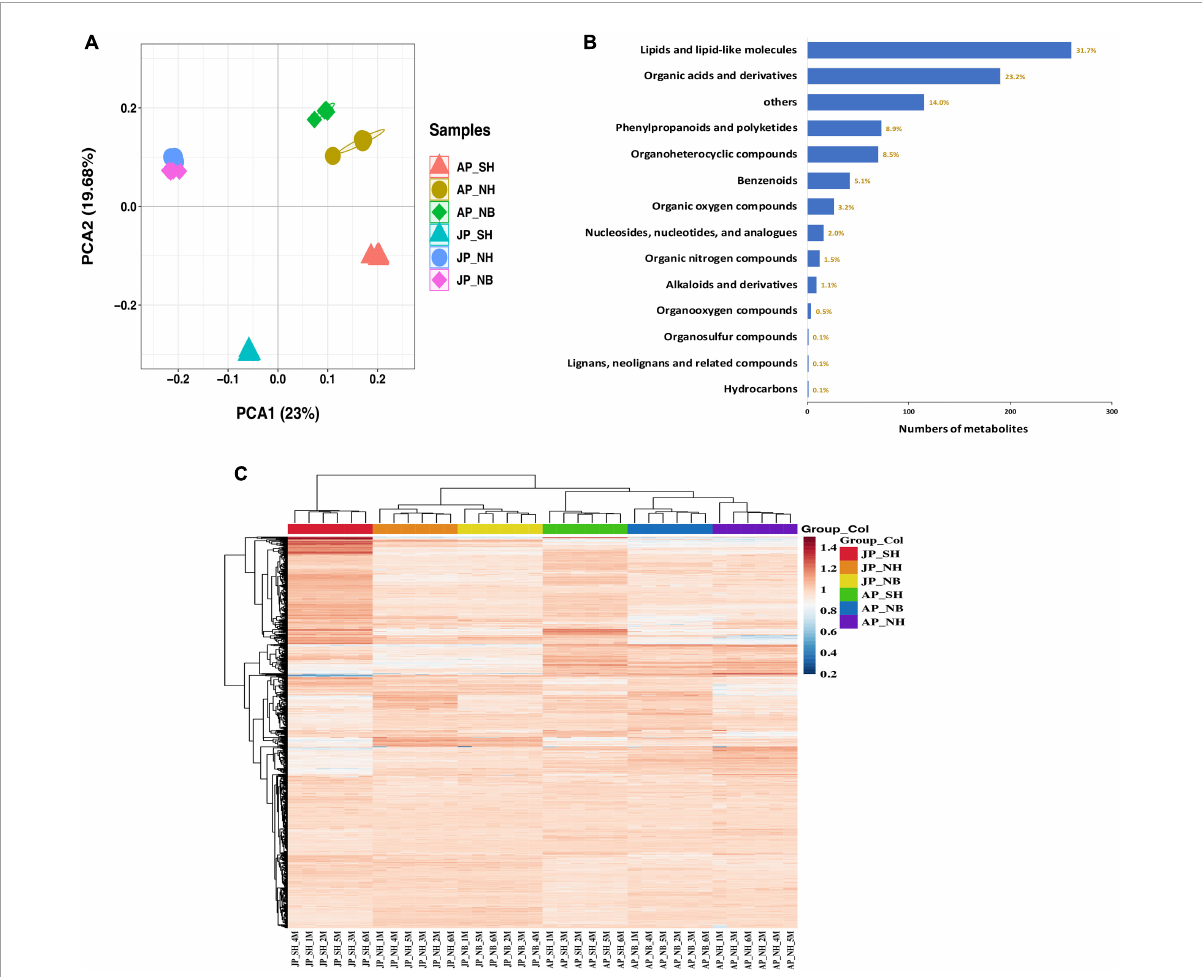
FIGURE2 Preliminary analysis of metabolites data. (A) Principal component analysis (PCA) score plot metabolite profiles from different groups. (B) All metabolite types and quantities. (C) The clustering heat maps of all